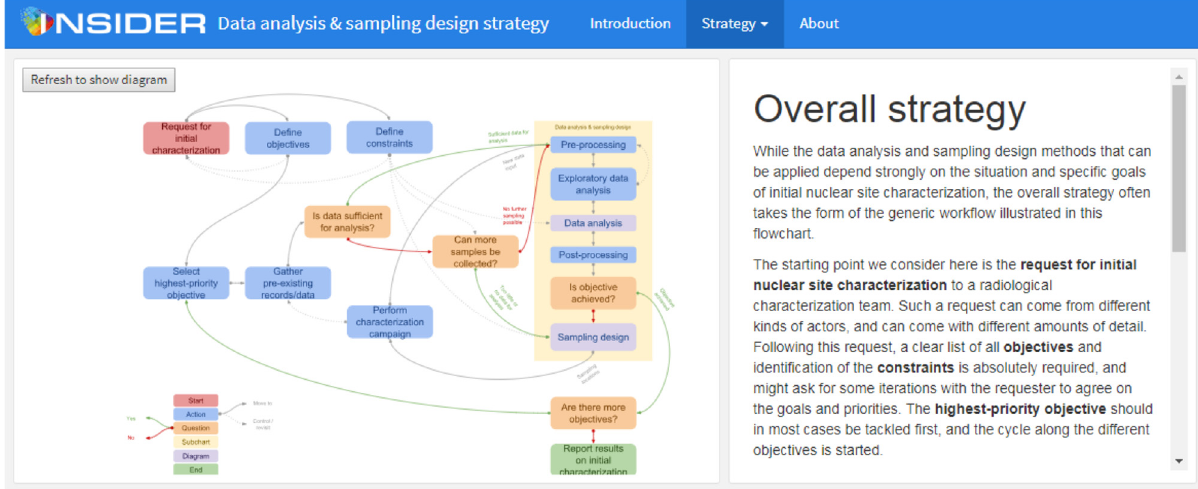
Fig. 7. General view of the user-friendly interface to the strategy for data analysis and sampling design.